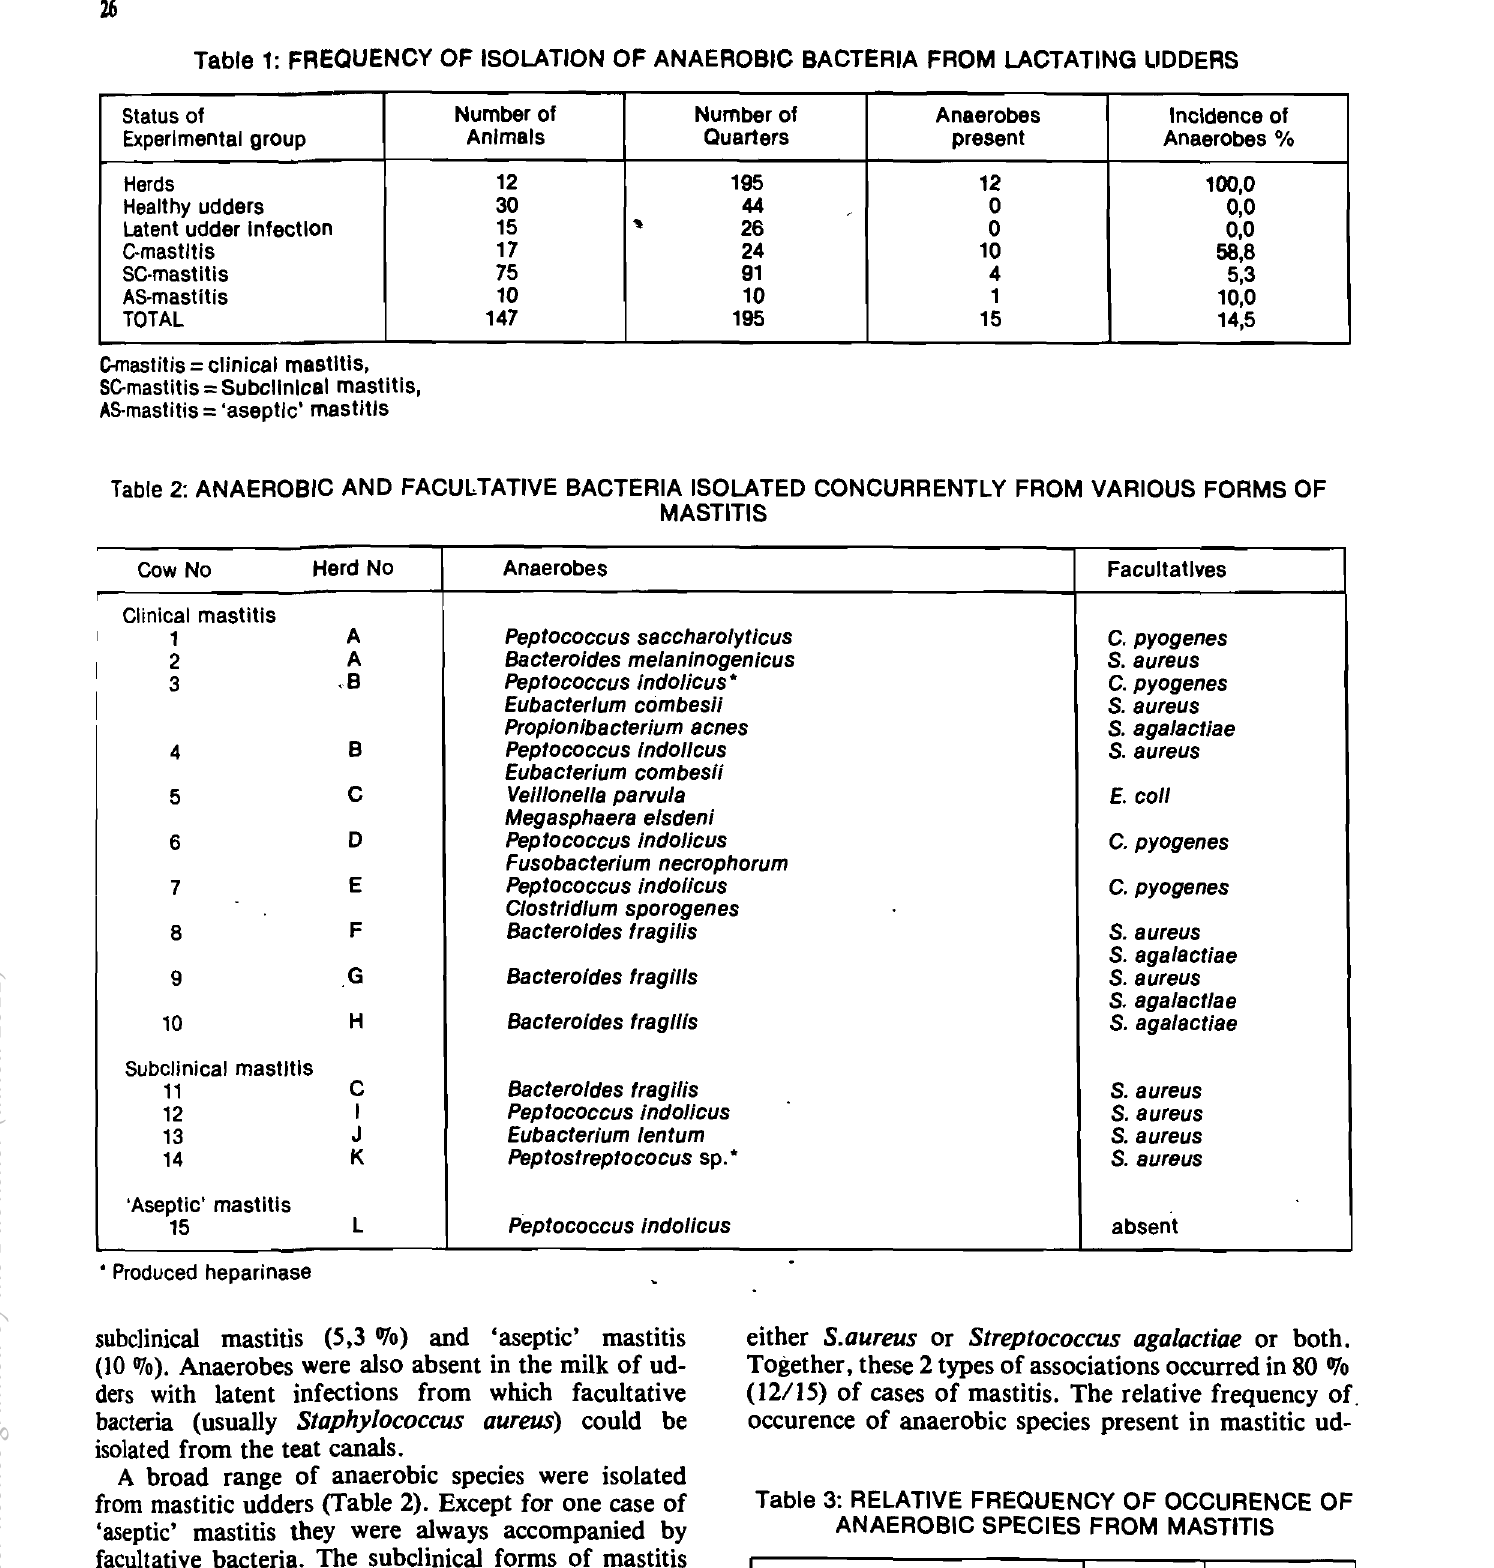
Table 1: FREQUENCY OF ISOLATION OF ANAEROBIC BACTERIA FROM LACTATING UDDERS Status of Experimental group Herds Healthy udders